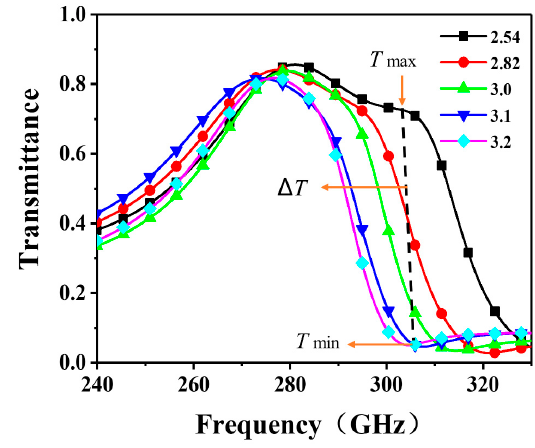
Figure 3. Simulated transmittance spectra for di ff erent dielectric